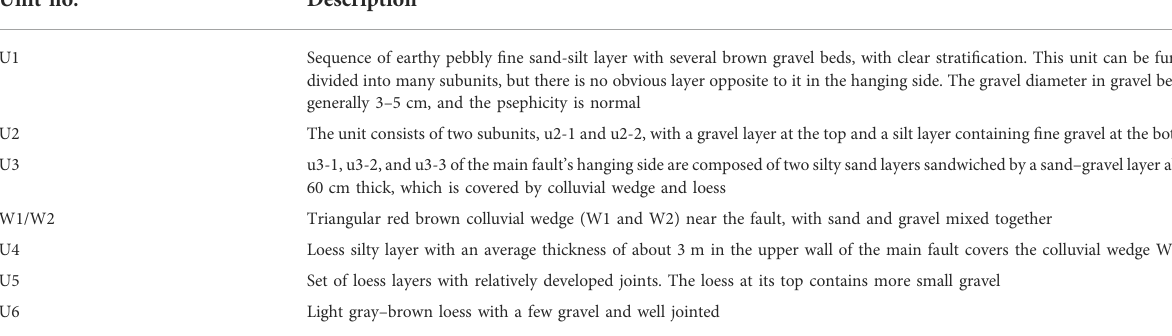
TABLE 1 Unit descriptions from the exposed walls of the Xujiabao trench. Unit no.